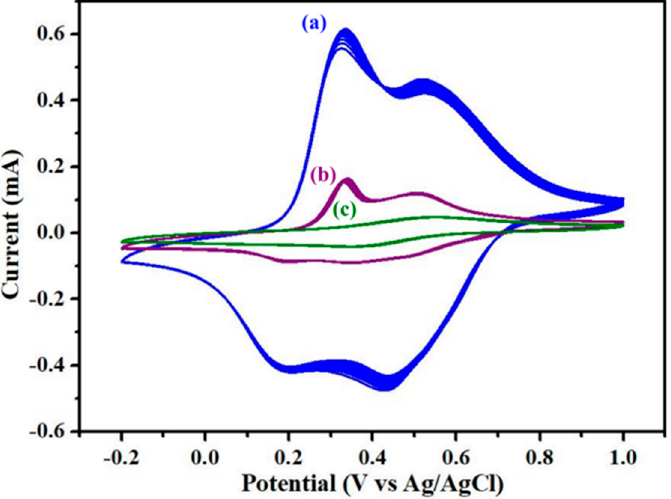
Figure 4. Cyclic voltammetry of ( a ) AT, ( b ) EAAO and ( c ) EIO were measured 10 cycles in aqueous H 2 SO 4 (1.0 M) with scan rate of 50 mV s − 1 .